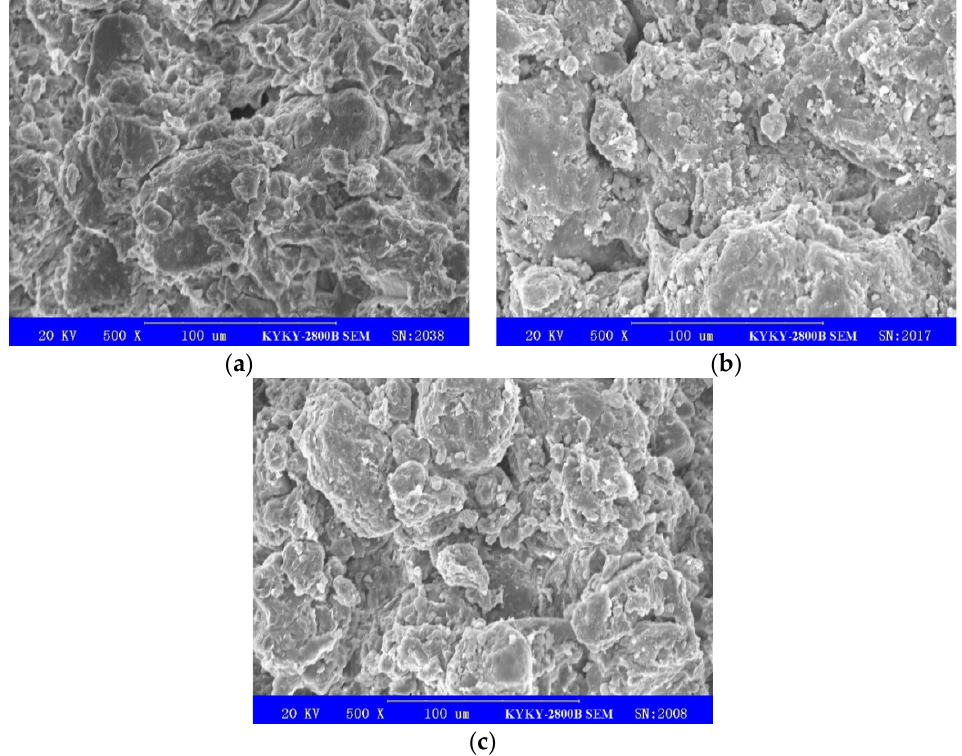
Figure 5. SEM image of soil sample. ( a ) 0 F–T cycle; ( b ) 1 F–T cycle; ( c ) 5 F–T cycle. Analysis of the images revealed that the particles of SC specimens without freeze–thaw cycle are closely connected and present a plate-like structure as a whole. After one F–T cycle, the compact connections between the particles are broken and the sample shows cracks. With the continuation of a F–T cycle, the sample structure was significantly different from that before freezing and thawing, especially the connectivity between soil particles was significantly reduced. The microstructure of the sample becomes looser and larger pores began to form between the soil particles. In order to quantitatively analyze the characteristics of pore changes after F–T cycles, IPP (Image Pro Plus) software was used to statistically analyze the porosity and average diameter of the samples. Before this, the original image needs to be binarized to accurately identify the pores in the image and remove the small and irregular noise points by selecting an appropriate threshold. Based on the observation of the statistical data, the pore size was divided into small pores ( d < 2 µ m), medium pore (2 < d < 5 µ m), and large pores ( d > 16 µ m). The results are shown in Table 3. Table 3. Pore parameters after F–T